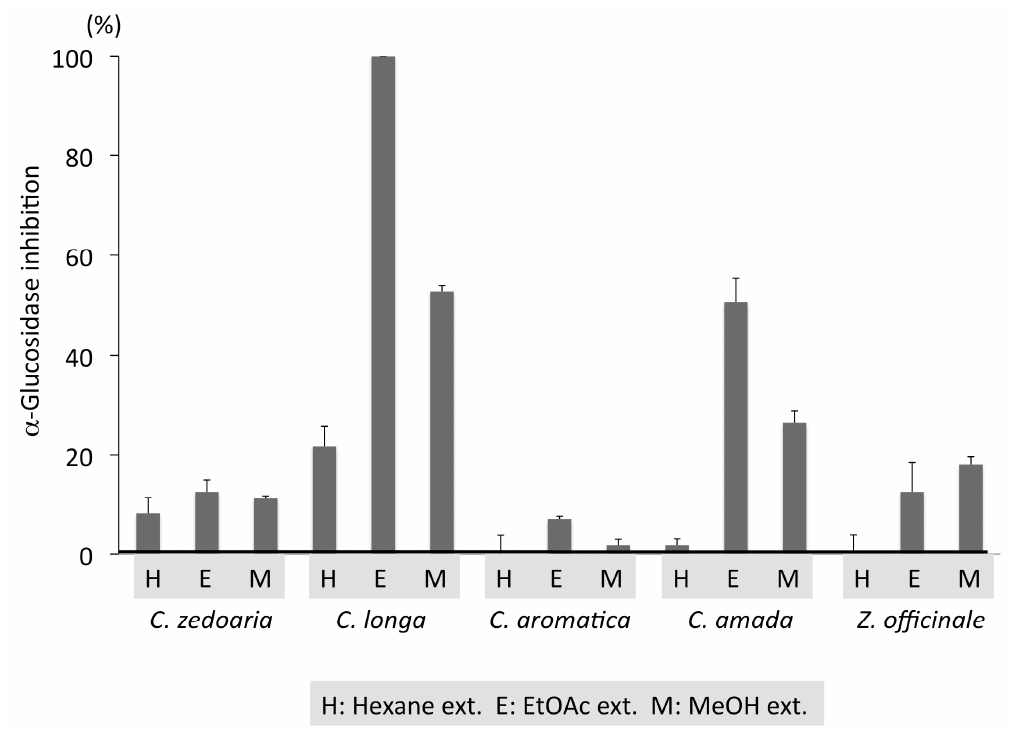
Figure 1. α -Glucosidase inhibitory activity of Zingiberaceae extracts against α -glucosidase from rat intestine acetone powder. Values are means ± SD ( n = 3).